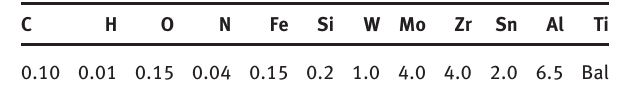
Table 1: Chemical composition of BT25y titanium alloy(mass frac- tion, %).